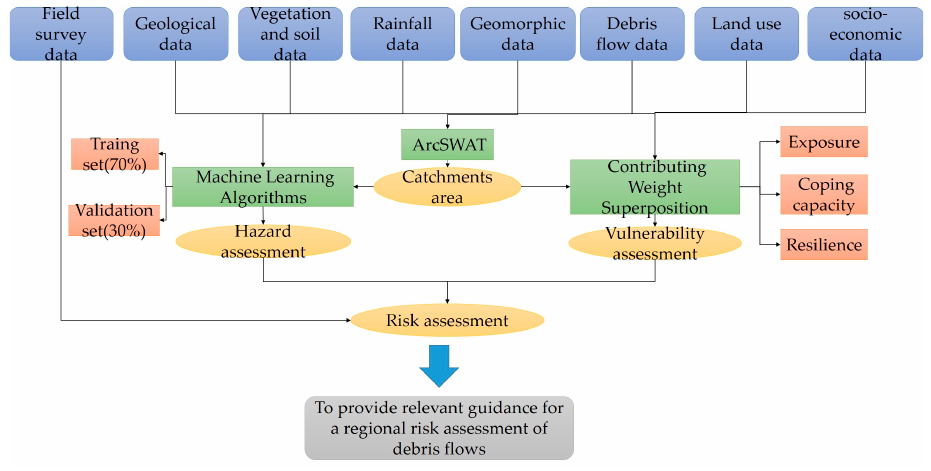
Figure 2. Technical flow chart of this study.